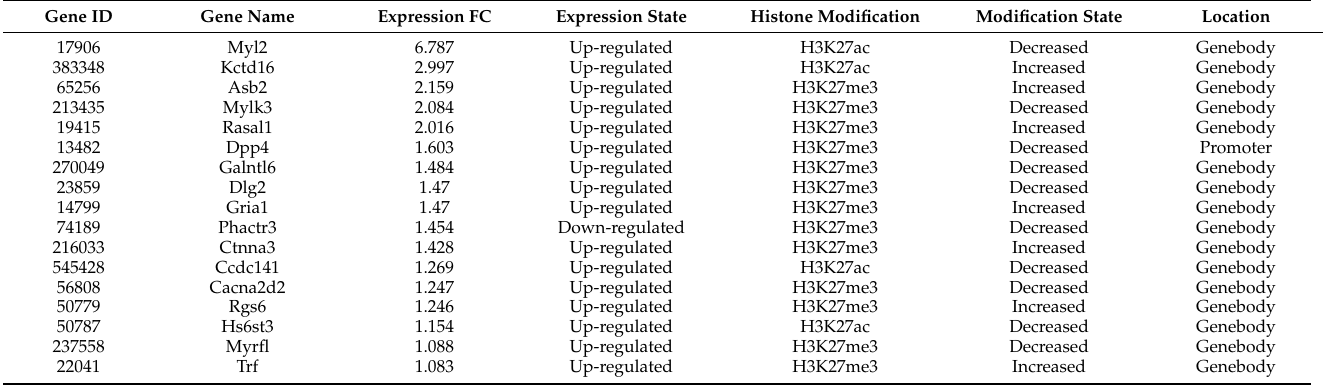
Table 1. The differentially expressed genes with histone modifications unique for E9.5 BaP-NTD